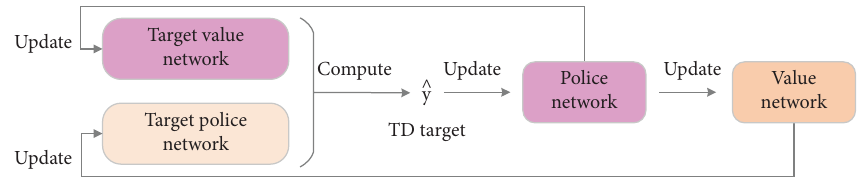
Figure 9: Relationship between four neural networks.